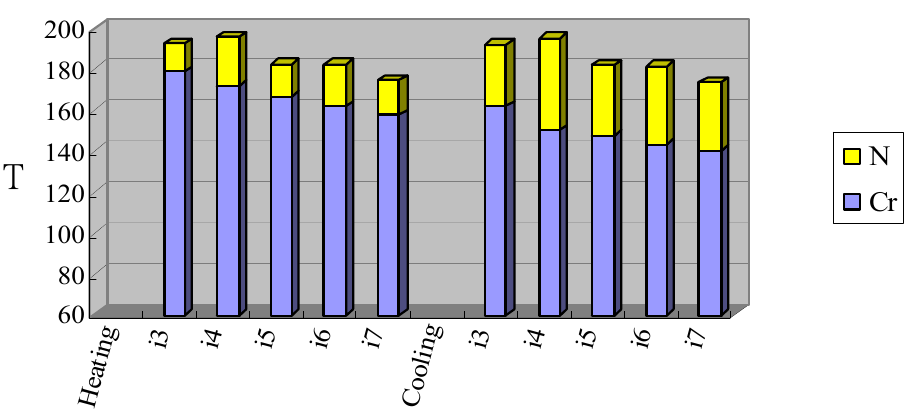
Figure 4. Plot of transition temperatures of heating and cooling cycle for compounds of 2-(6-alkoxynaphthalen-2-yl)-6-methylquinolines ( i O-NpQMe, i =